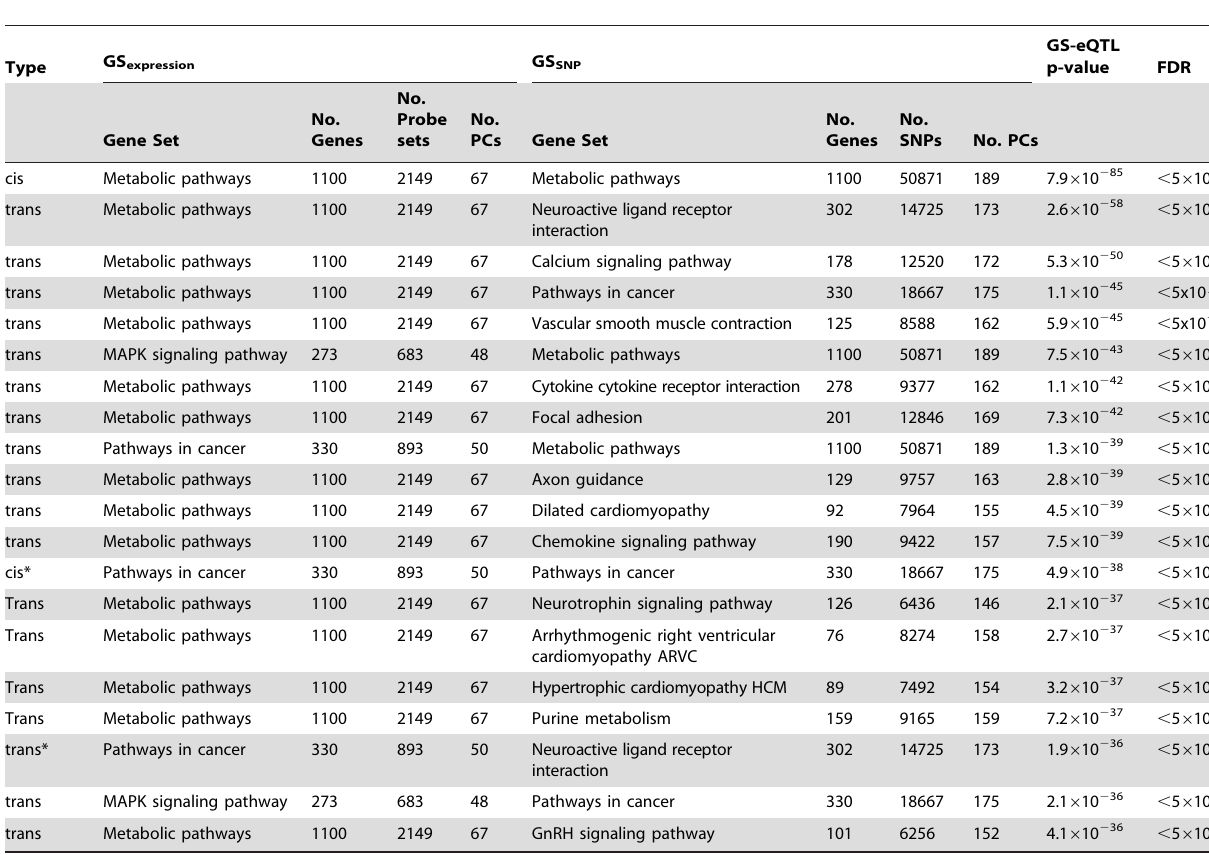
Table 3. Top 20 KEGG GS-eQTL associations after removing the genes within the HLA region.